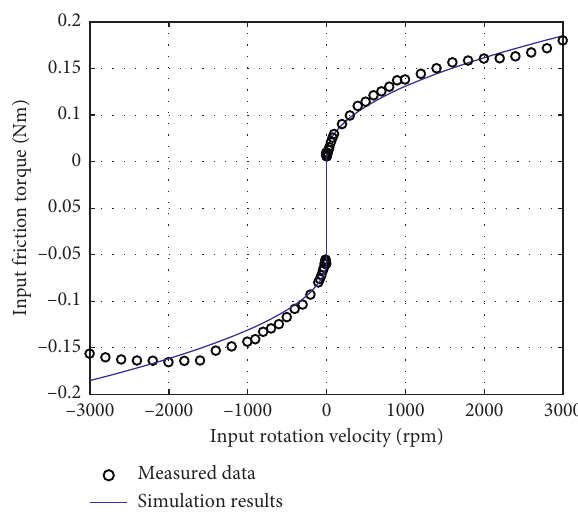
Figure 7: Measured friction torque and simulation results of nonlinear friction